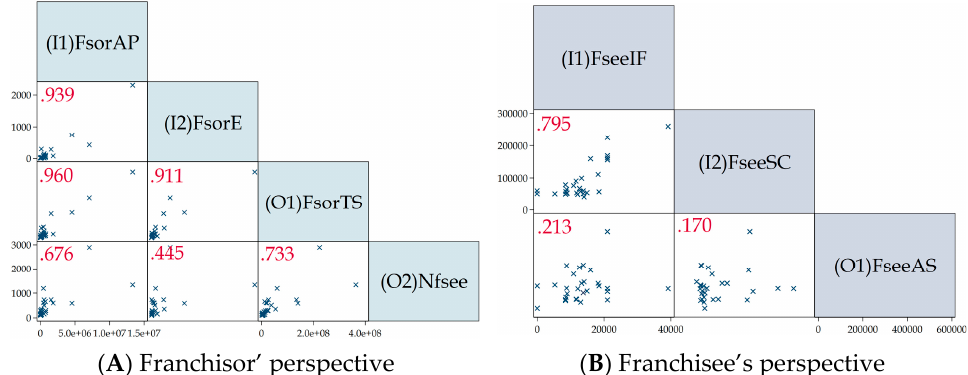
Figure 3. Pearson correlation analysis between input and output variables: ( A ) franchisor’s perspective; ( B ) franchisee’s perspective.